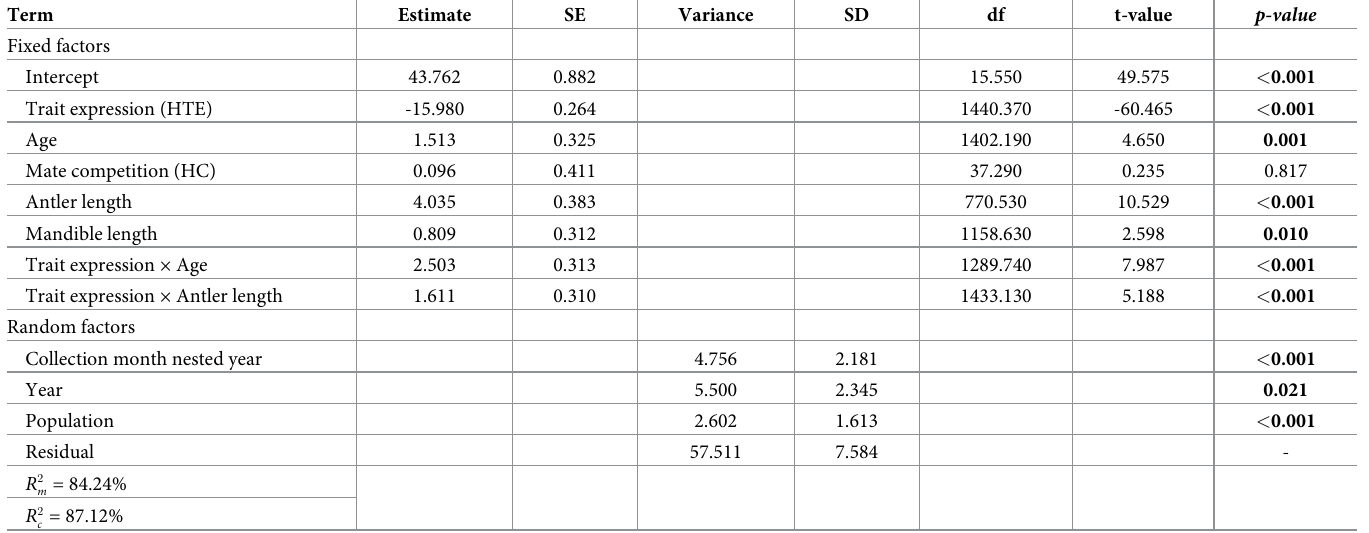
Table 1. Factors influencing variability in the dark ventral patch